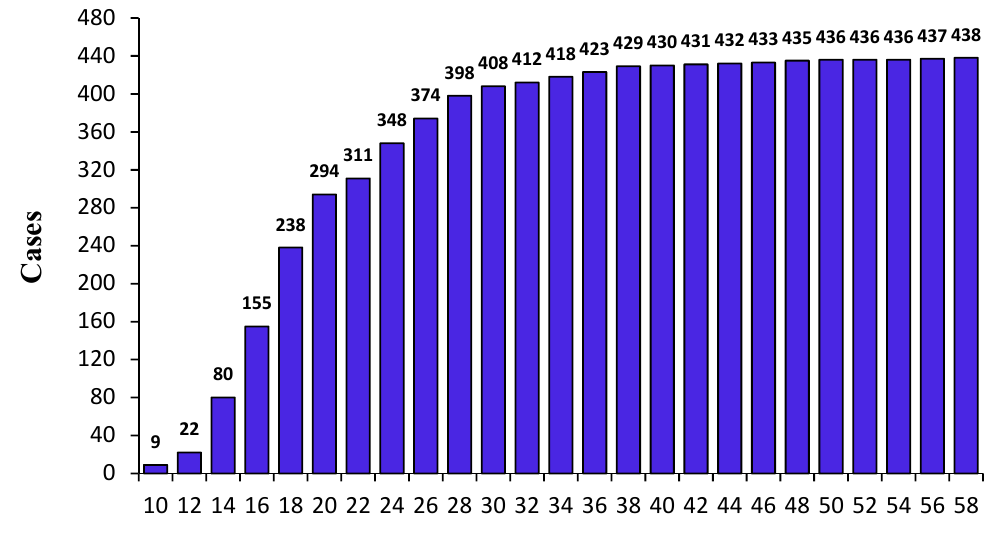
Figure 13. Bias curve of the Weather Research and Forecasting (WRF) model relative to observed precipitation. The red line shows its second-order polynomial fit curve.